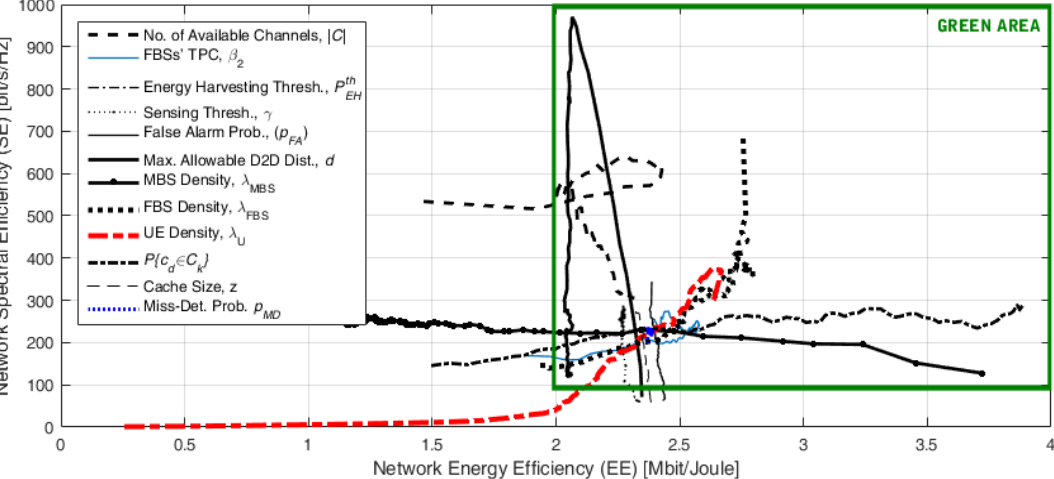
Figure 18. The sensitivity of the spectral efficiency (SE) and energy efficiency (EE) with respect to variations of the network parameters.